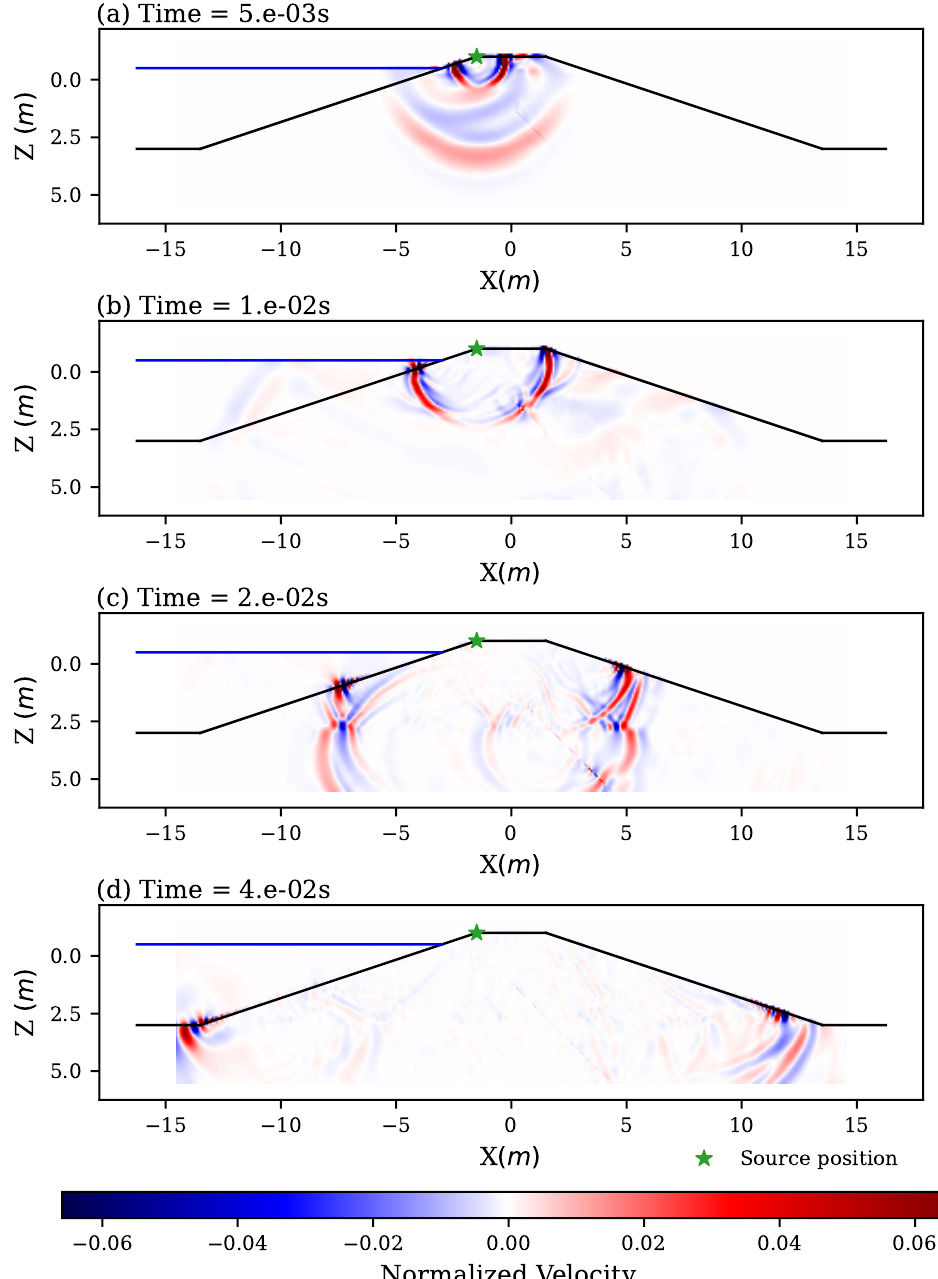
Figure 11. Vertical component of particle velocity ( v z ) , normalized to the velocity wavelet at the excitation point, in the forward seismic